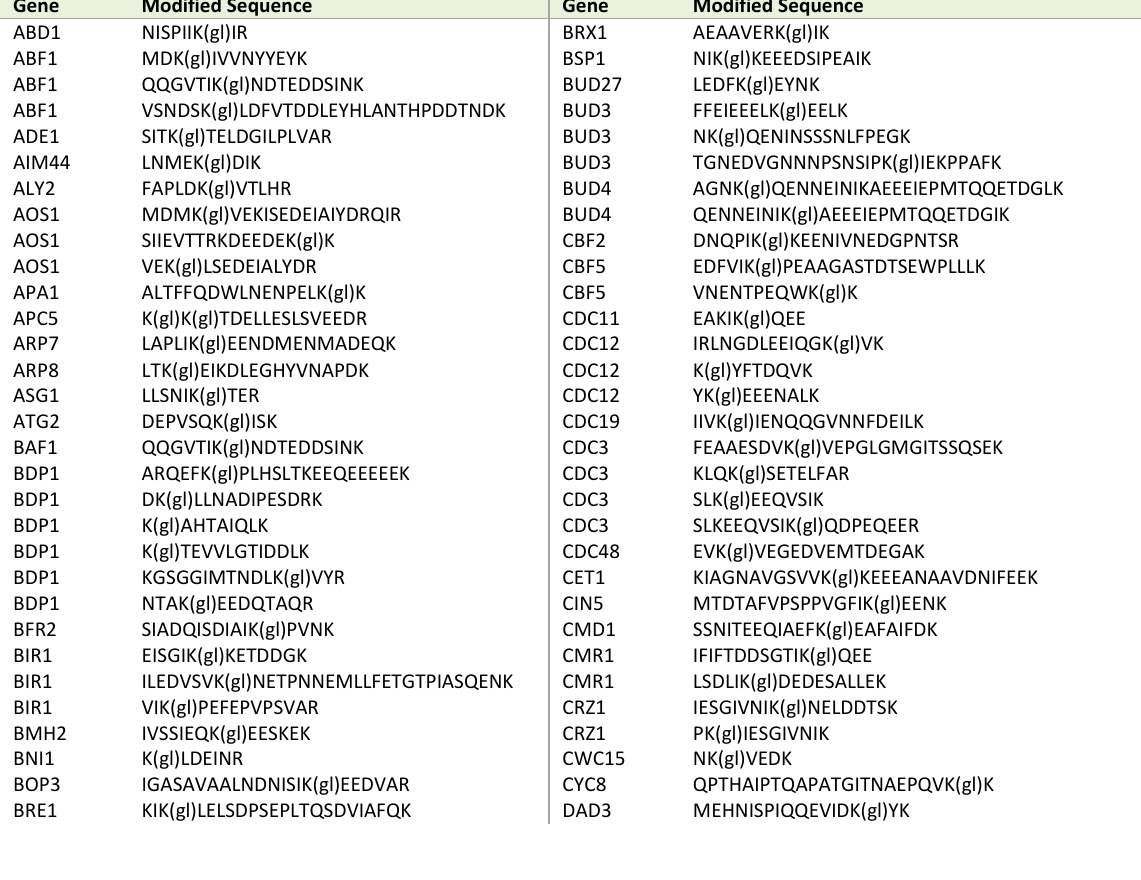
TABLE 1. Summary of all sumo-acceptor lysines detected by mass